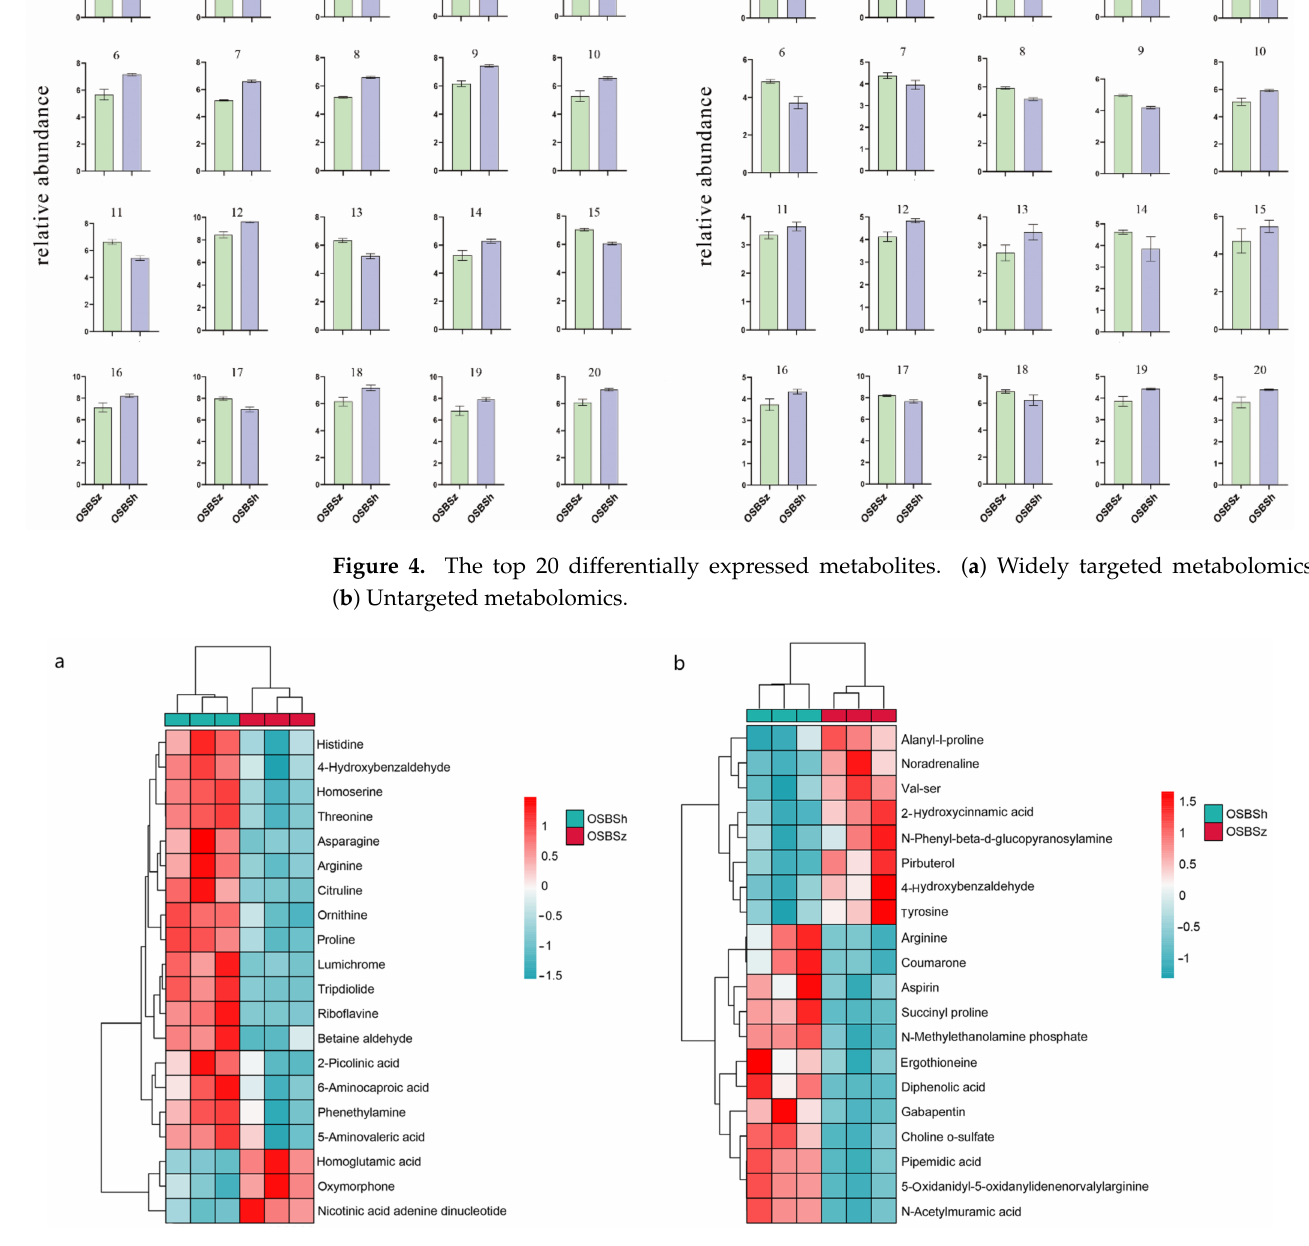
Figure 5. Hierarchical cluster analysis for OSBSz and OSBSh. ( a ) Widely targeted metabolomics. ( b ) Untargeted